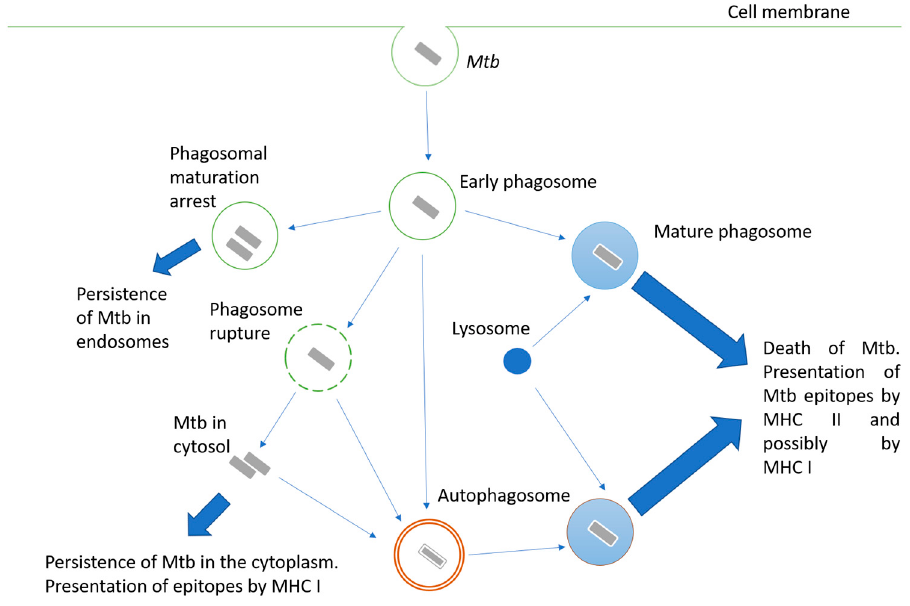
Figure 1. Intracellular fate of a bacterium engulfed by a phagocyte. Description is in the text.